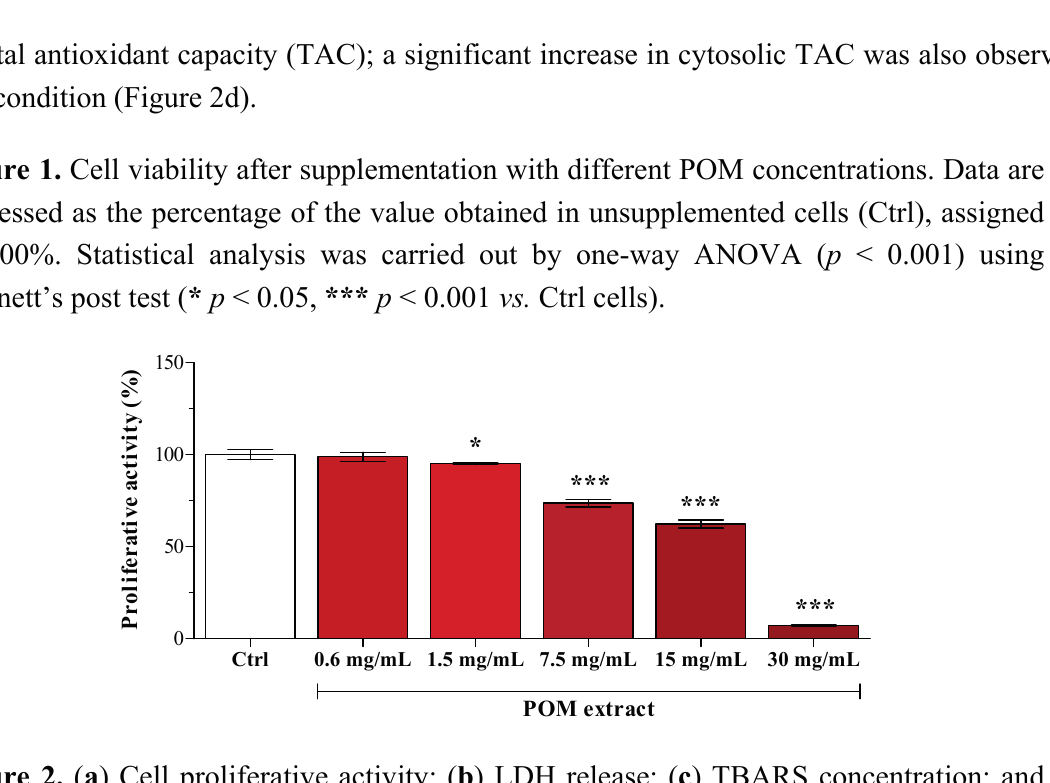
Figure 2. ( a ) Cell proliferative activity; ( b ) LDH release; ( c ) TBARS concentration; and ( d ) TAC of unsupplemented and supplemented cells in basal and stressed conditions. Data in panels a , b and c are expressed as the percentage of the value obtained in not stressed Ctrl cells (assigned as 100%), while TAC (panel d ) is expressed as micromoles of trolox equivalent (TE) per mg protein. Statistical analysis was carried out by one-way ANOVA (panels a , b , and c p < 0.001; panel d p < 0.01) using Tukey’s HSD test. Different letters indicate statistical significance (at least p < 0.05).